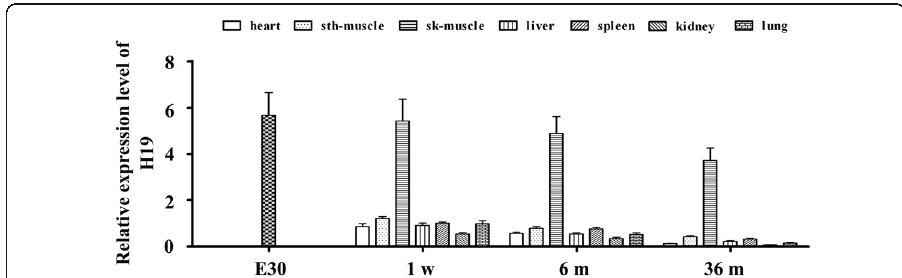
Fig. 1 The expression profiles of H19 in various tissues from male cattle of different postnatal stages. GAPDH RNA is the reference gene. The relative expression in satellite and C 2 C 12 cells during differentiation was calculated according to the 2 - ΔΔ Ct method. sth-muscle: smooth muscle; sk-muscle: tibia skeletal muscle; 1w: six 1-week old cattle, 1 m: 1-month old cattle, 6 m: 6-month old cattle, 36 m: 36-month old cattle. E30: samples from embryos after one month of development. The error bars were calculated